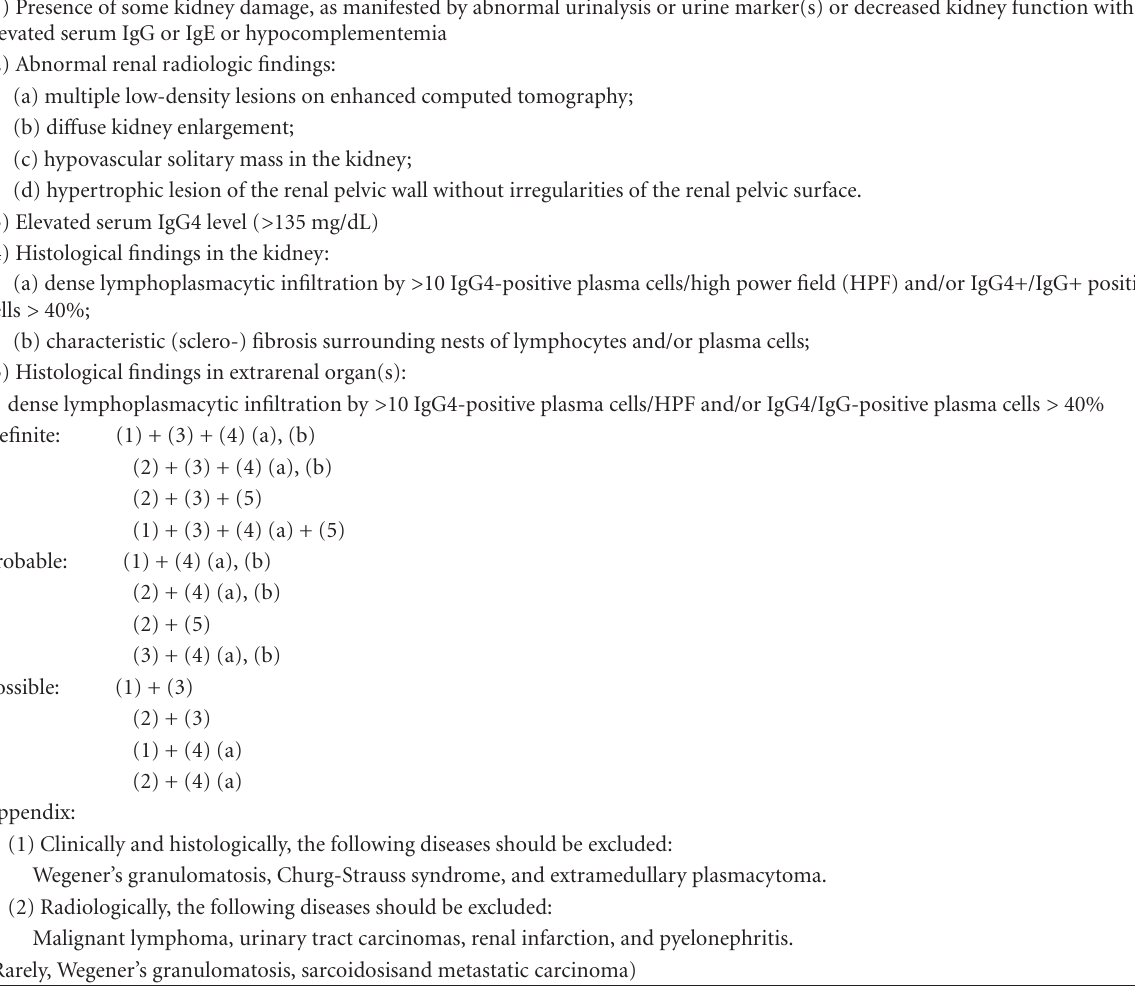
Table 4: Diagnostic criteria for IgG4-related kidney disease [14].